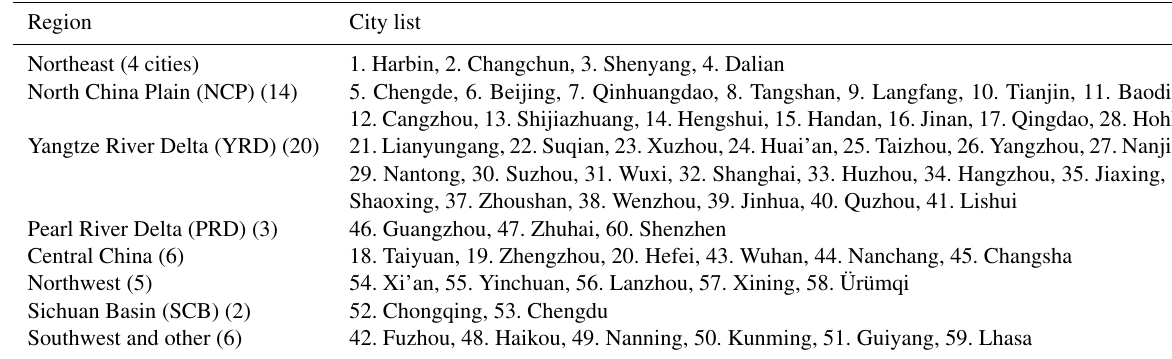
Table 2. List of the cities in different regions with available observations. Region City